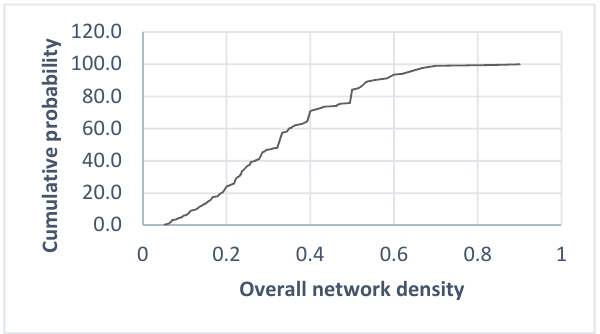
Figure 2. Cumulative probability distribution of the overall network density.